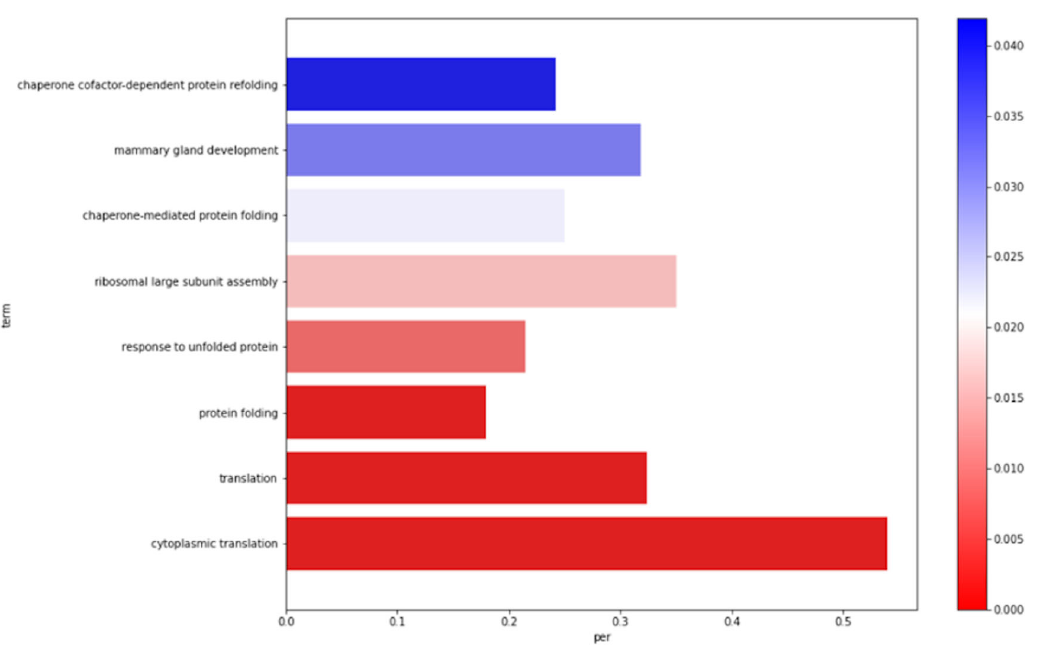
Figure 1. Example Barplot of statistically significant ontologies associated with differentially expressed